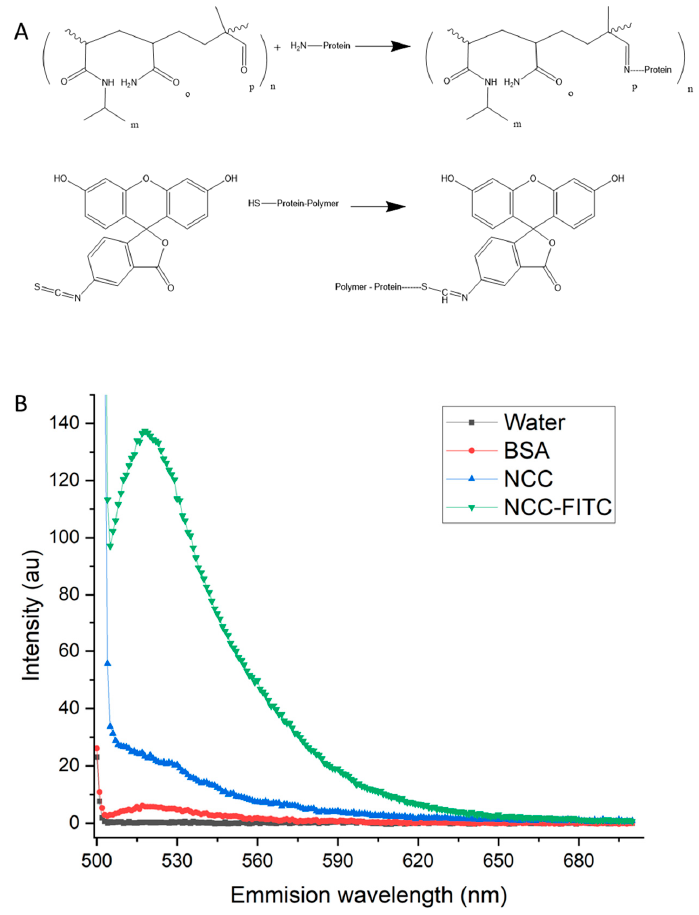
Figure 6. Mechanism and result of FITC binding to the NCC. ( A ) The reaction scheme detailing protein binding to the copolymer present on the NCC and the subsequent attachment of the fluorophore FITC to the bound protein. ( B ) The NCC-exhibiting fluorescence signal following binding with FITC. Fluorescence spectrum from 500 to 650 nm of water, 1 mg/mL solution of BSA, NCC, and NCC-FITC. The excitation wavelength of the sample was 495 nm flash lamp, and the emission spectrum was measured between 500 nm and 700 nm. Water